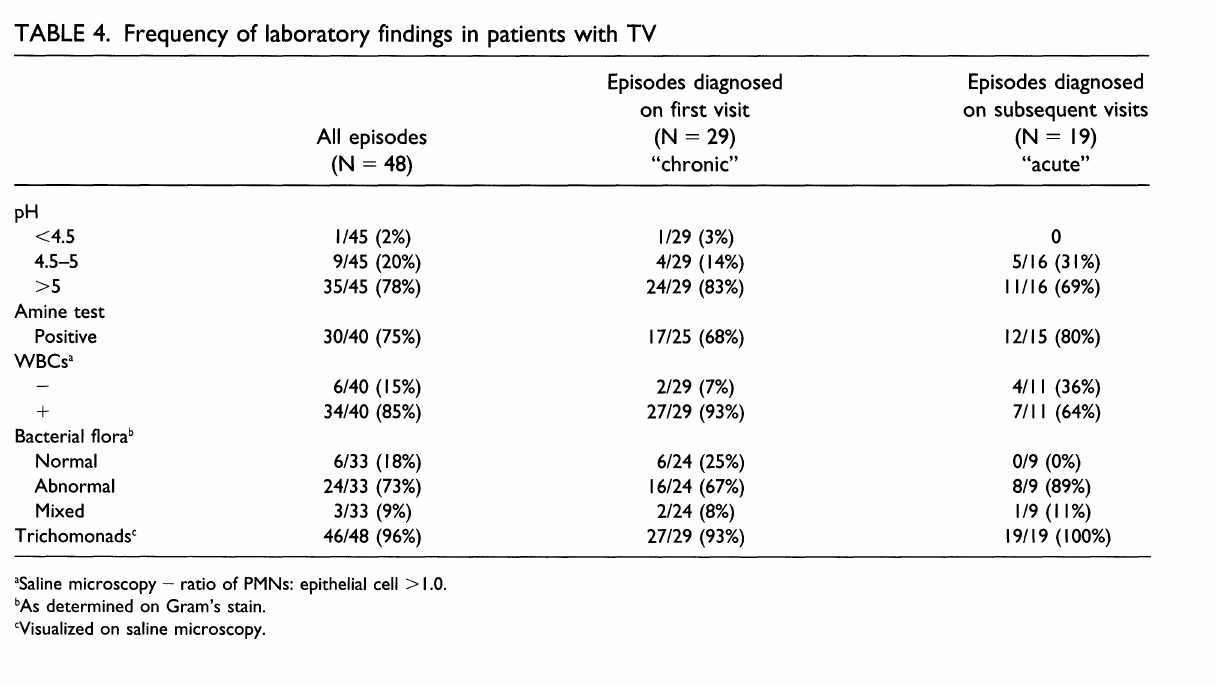
TABLE 4. Frequency of laboratory findings in patients with TV pH